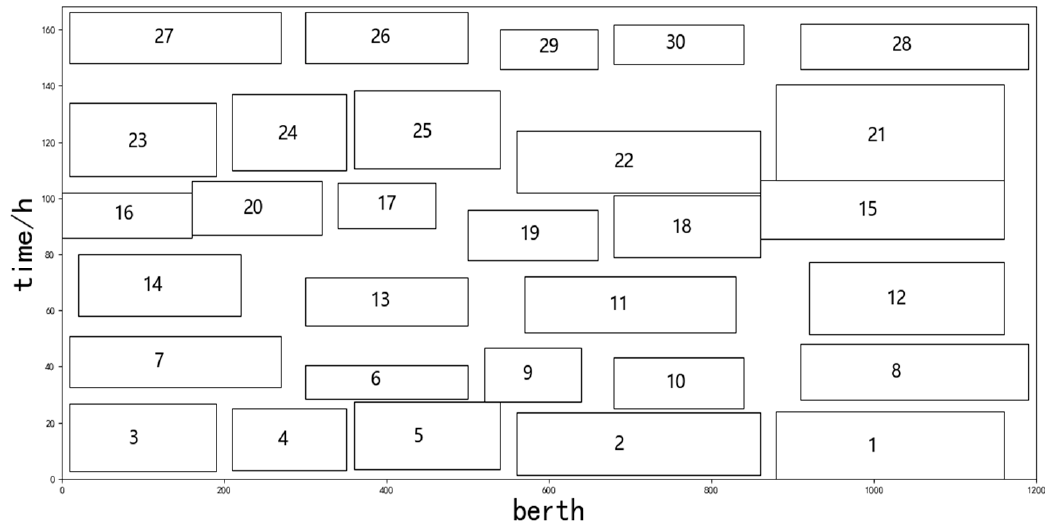
Figure 5. Baseline plan diagram .